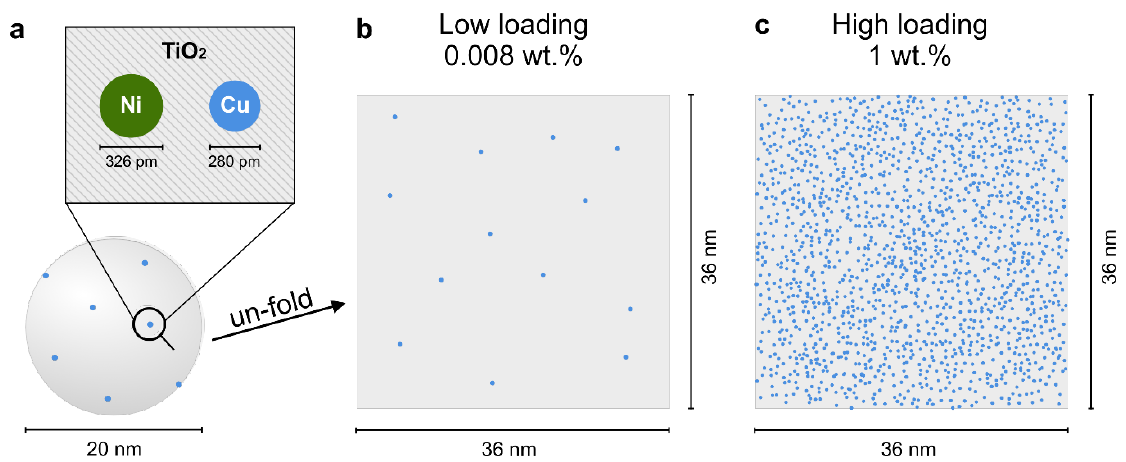
Figure 1. Graphical representation of the site-isolation strategy showing: ( a ) single TiO 2 nanoparticle and scaled Cu and Ni atoms (the representation is based on the surface area values), as well as its unfolded surface for ( b ) low co-catalyst loading of 0.008 wt.% (13 Cu atoms) and ( c ) high co-catalyst loading of 1 wt.% (1586 Cu atoms).